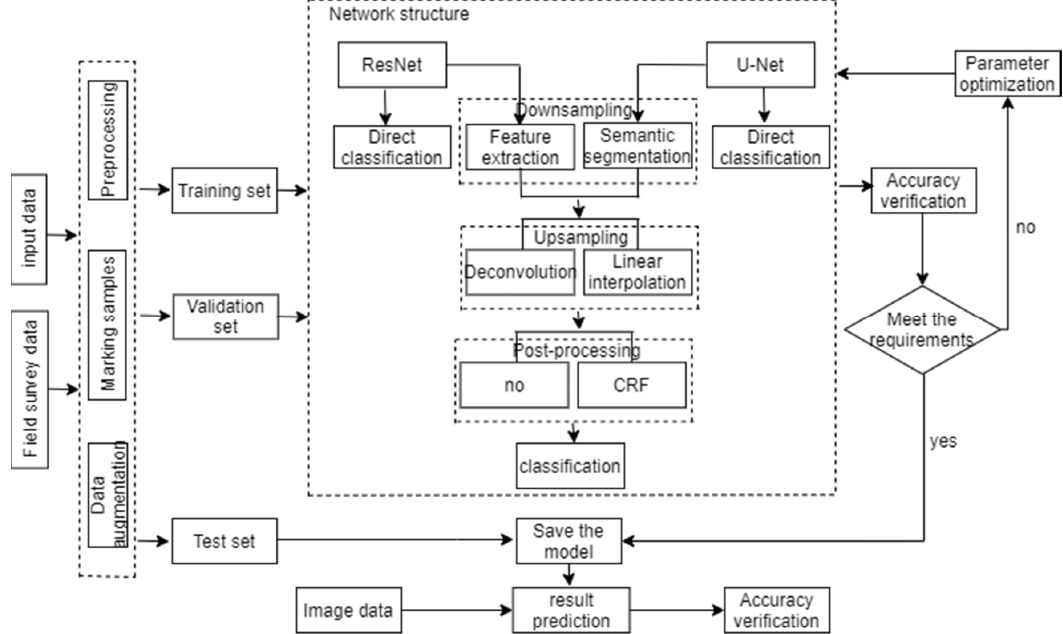
Figure 2. Workflow for improved U-Net model for tree species classification based on airborne high-resolution images.